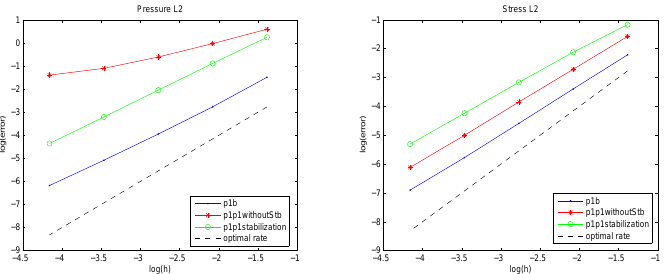
Figure 2. A pictorial representation of convergence rate by using the lowest equal order FE triples for the pressure L 2 ( left ); for stress L 2 ( right